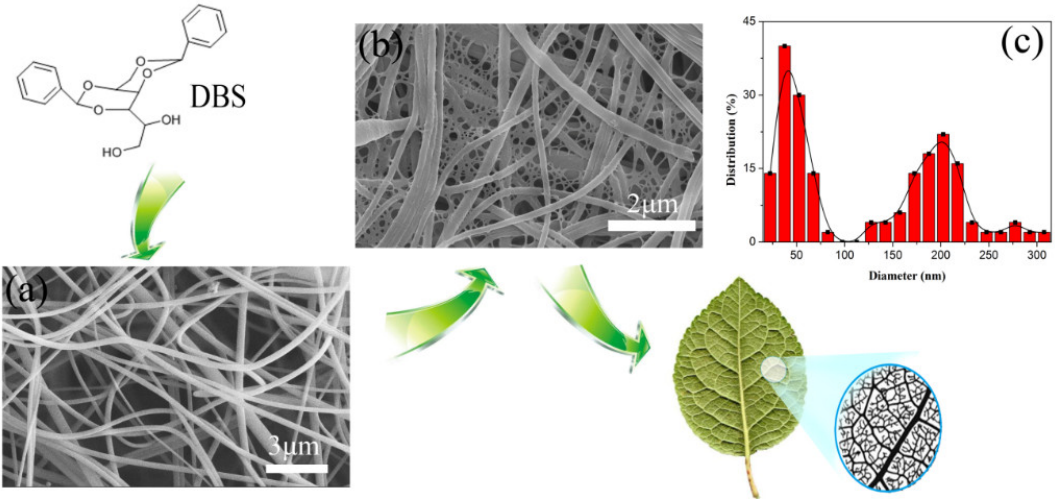
Figure 1. SEM of ( a ) sulfonated poly (ether sulfone) (SPES) solution-blown nanofibers and ( b ) 1,3:2,4-dibenzylidene-d-sorbitol (DBS)/SPES nanofibers; ( c ) the corresponding diameter distribution map of DBS/SPES.